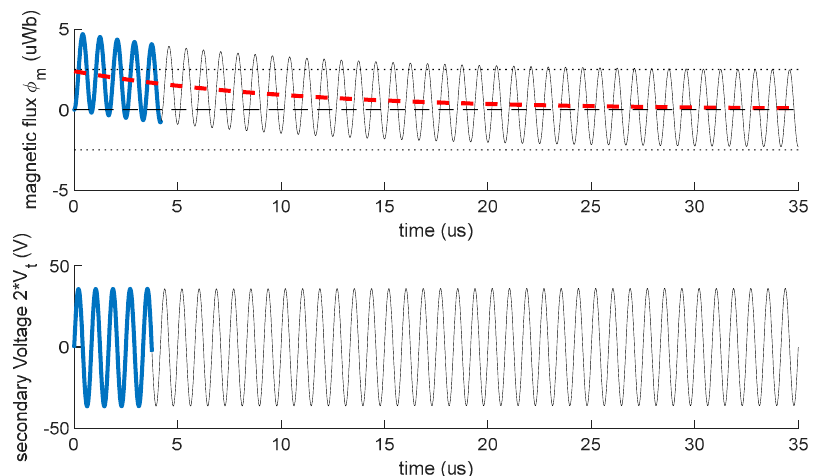
Figure 2. Magnetic flux ( top ), and voltage at load ( bottom ) for the described example. The magnetic flux features a transient with exponential decay of time constant, 𝛾 , and maximum near t = 0. Table 1. Values of the components for the circuit of Figure 1.